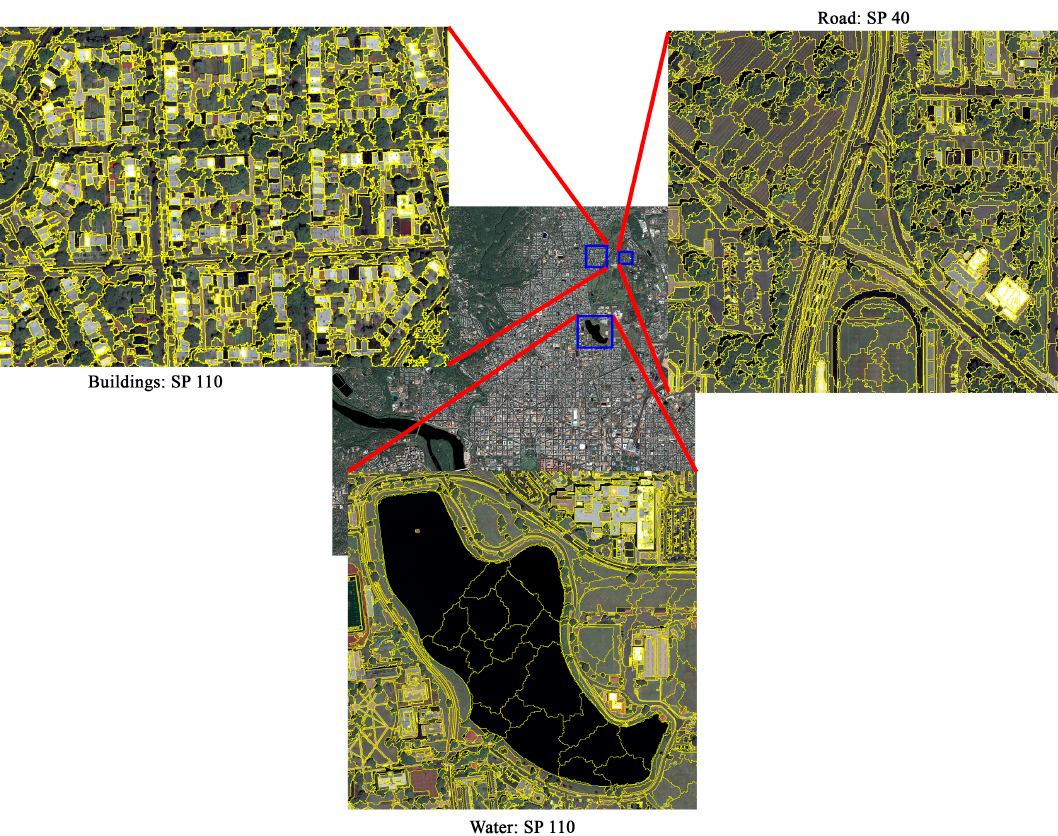
Figure 5. Segmentation results of the building, road, and water classes in the 50-cm test image.